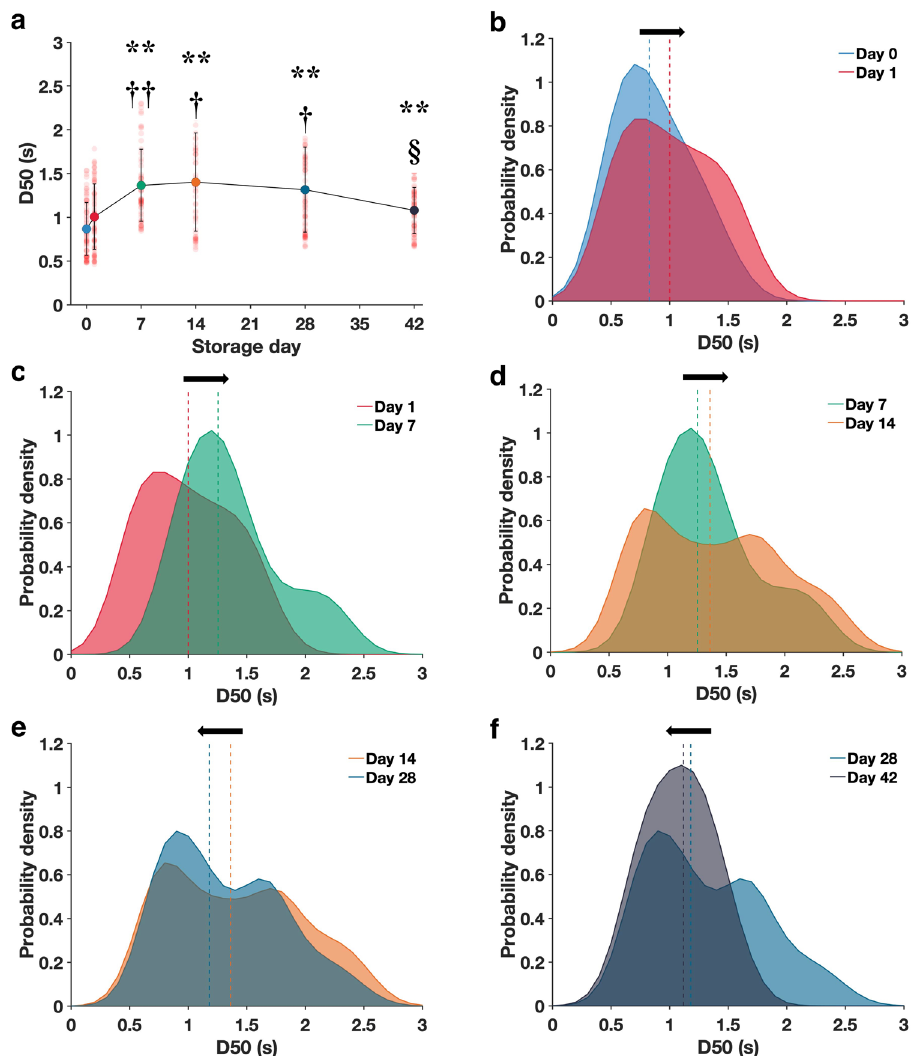
Fig. 4 Effect of in vitro aging during blood storage on the D50 of RBC. a D50 changes during storage (Day 0: n = 72, Day 1: n = 71, Day 7: n = 60, Day 14: n = 55, Day 28: n = 75 and Day 42: n = 65 of biologically independent RBCs). b – f Probability distribution of D50 for each respective storage day: Day 0 (light blue), Day 1 (red), Day 7 (green), Day 14 (orange), Day 28 (dark blue), and Day 42 (black). Broken lines represent the median values of D50. The signi fi cant difference relative to Day 0: * P < 0.05, ** P < 0.0001. The signi fi cant difference relative to Day 1: † P < 0.001, †† P < 0.0001. The signi fi